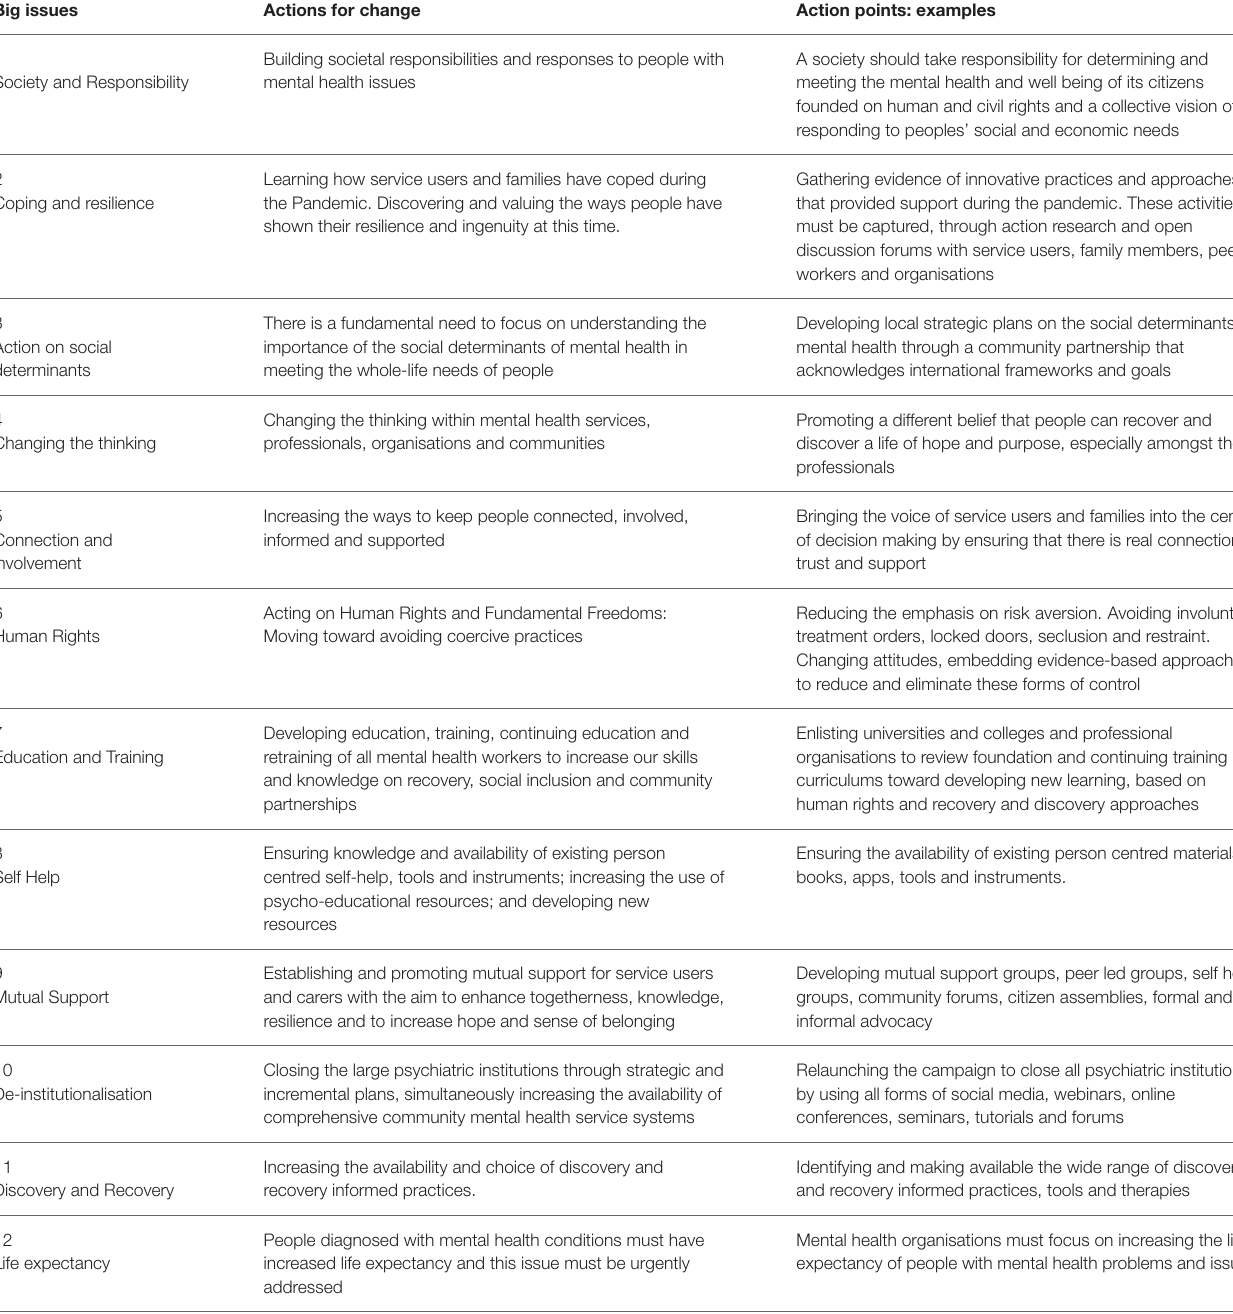
TABLE 1 | Big issues and actions for change: an international and local action plan 2020 − 2030. Big